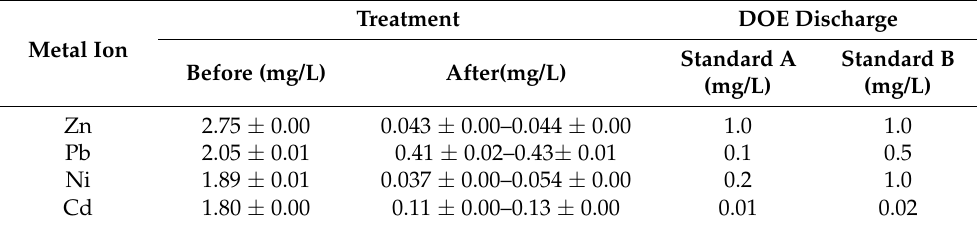
Table 1. Comparison of final treatment of heavy metals with the standard limit set by the Department of Environment (DOE), Malaysia at 120 mg/L of 10% TBPF at pH 10 in a 2.5 mg/L metal ion